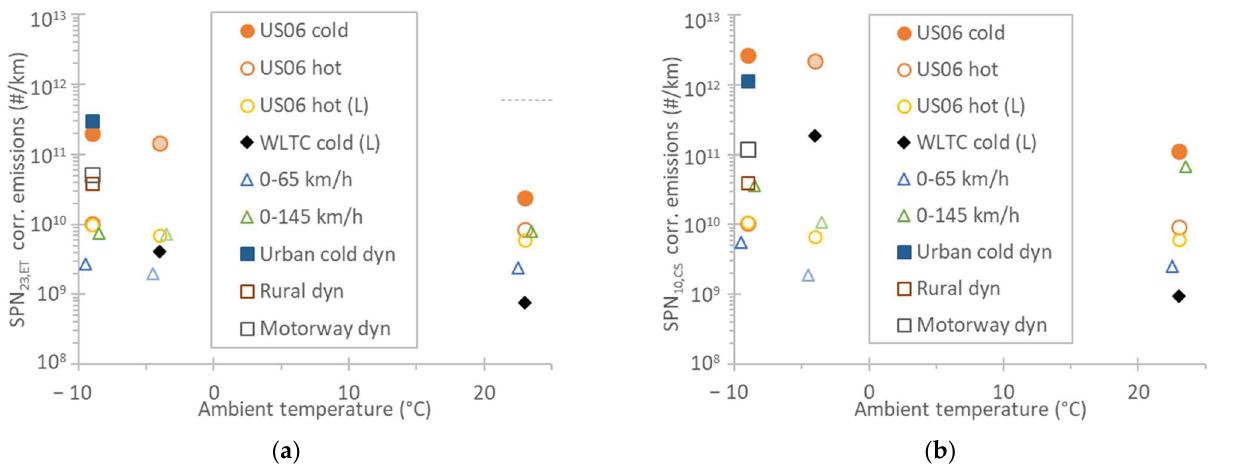
Figure A1. Emissions for various tests at different ambient temperatures applying the following corrections: CO 2 ratio, 1.6 for temperatures <0 °C, normalization to 16 km for cycles with shorter distance. All tests with 84% payload (1850 kg test mass), except those with “L” and the −4 °C tests where the test mass was lower (1550 kg). Solid symbols are cold start tests, while open symbols are hot start tests. Lighter colors indicate tests with lower payload (mass). Auxiliaries were activated only at the −9 °C tests. ( a ) Solid particle number >23 nm with the evaporation tube (SPN 23,ET ). The dotted line shows the limit for the type approval cycle WLTC. ( b ) Solid particle number >10 nm with the catalytic stripper (SPN 10,CS ).